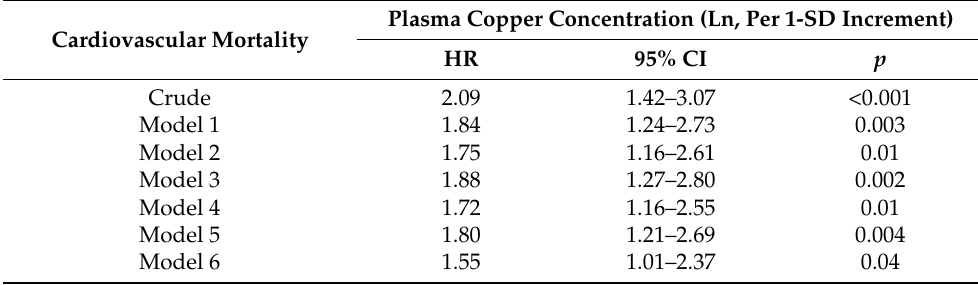
Table 3. Association between plasma copper concentration and cardiovascular mortality in male KTR. Plasma Copper Concentration (Ln, Per 1-SD Cardiovascular Mortality